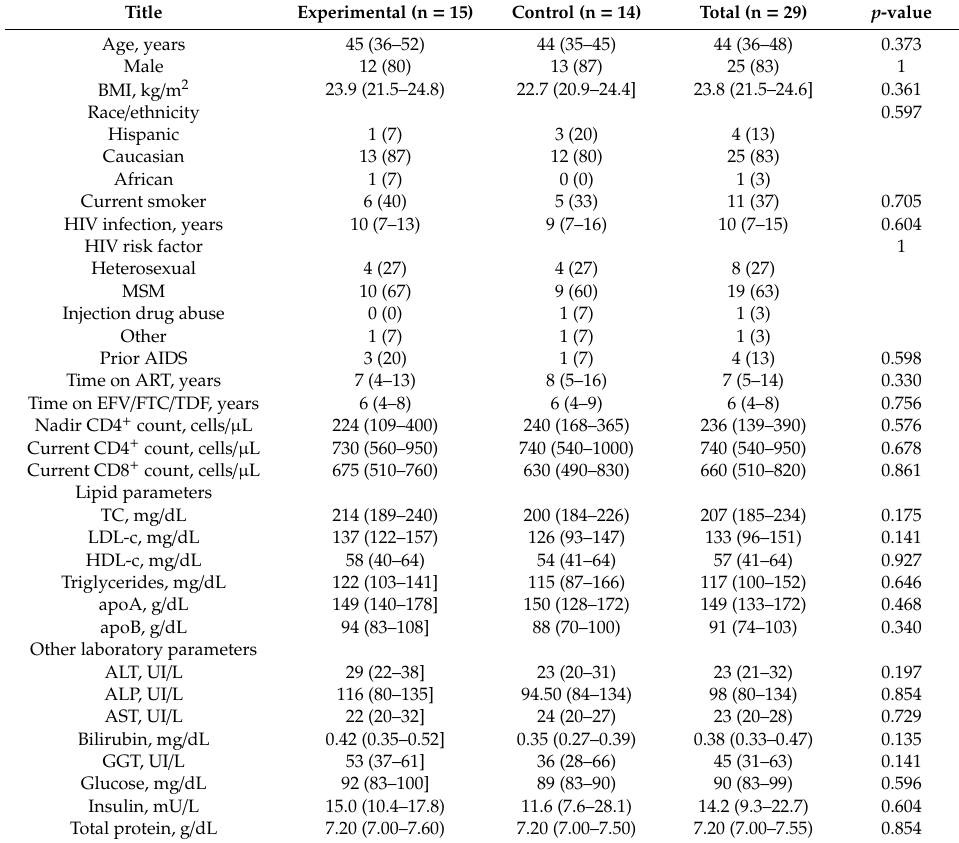
Table 1. Clinical and epidemiological baseline characteristics of the study